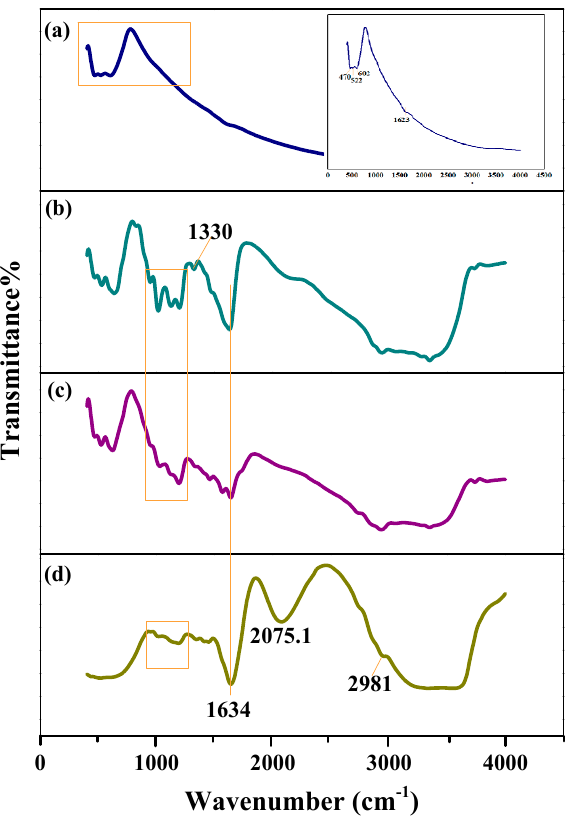
Figure 7. Fourier Transform Infrared Spectroscopy (FTIR) (500–4000 cm − 1 ) spectra of electrode modification: ( a ) SnNPs. Inset shows FTIR spectra in the range of 400–1500 cm − 1 . ( b ) Cys@SnNPs,